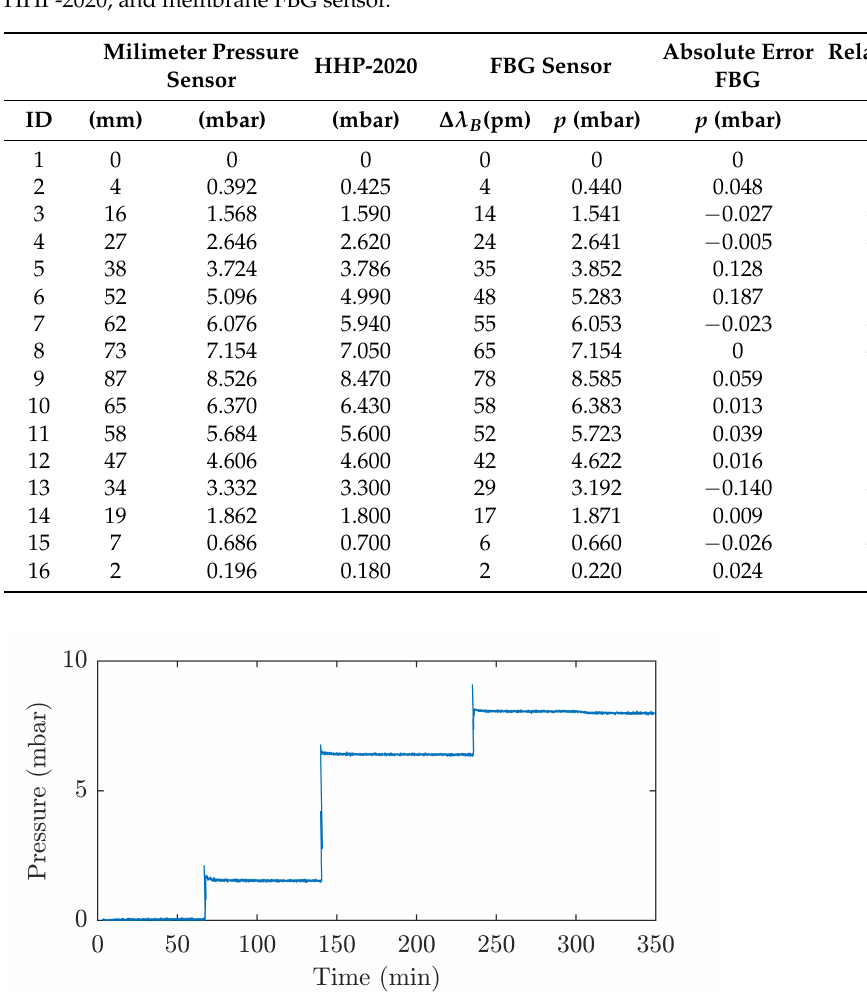
Table 1. Summary of pressure measurement with a millimeter column sensor, digital manometer HHP-2020, and membrane FBG sensor.